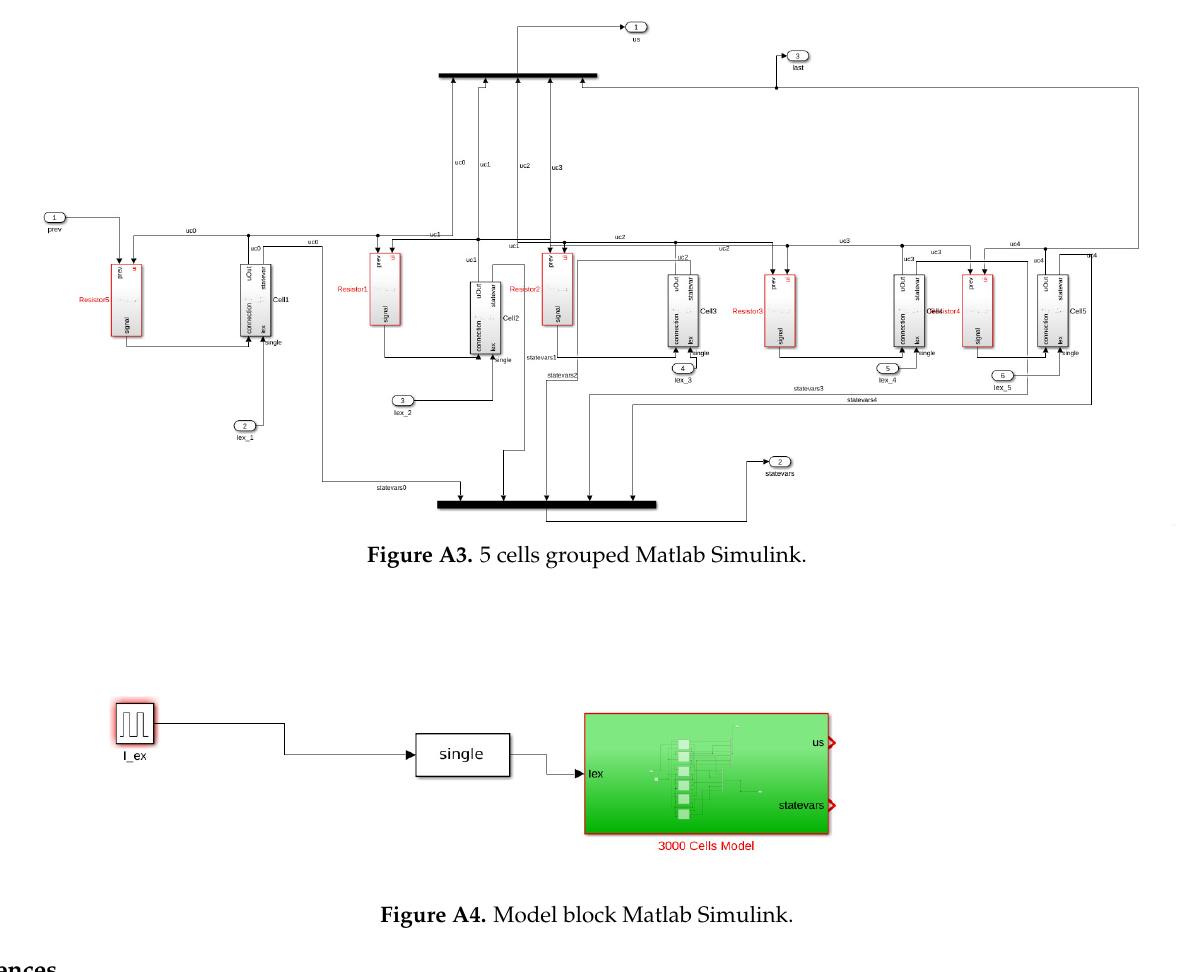
Figure A4. Model block Matlab